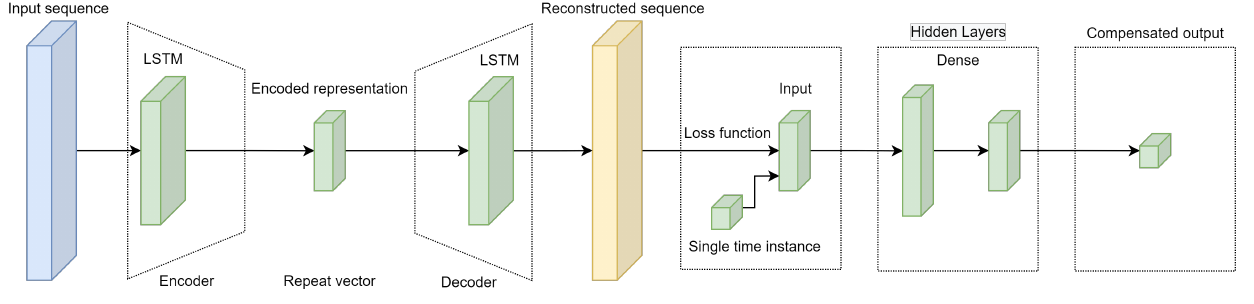
Figure 1. System diagram of the proposed method.